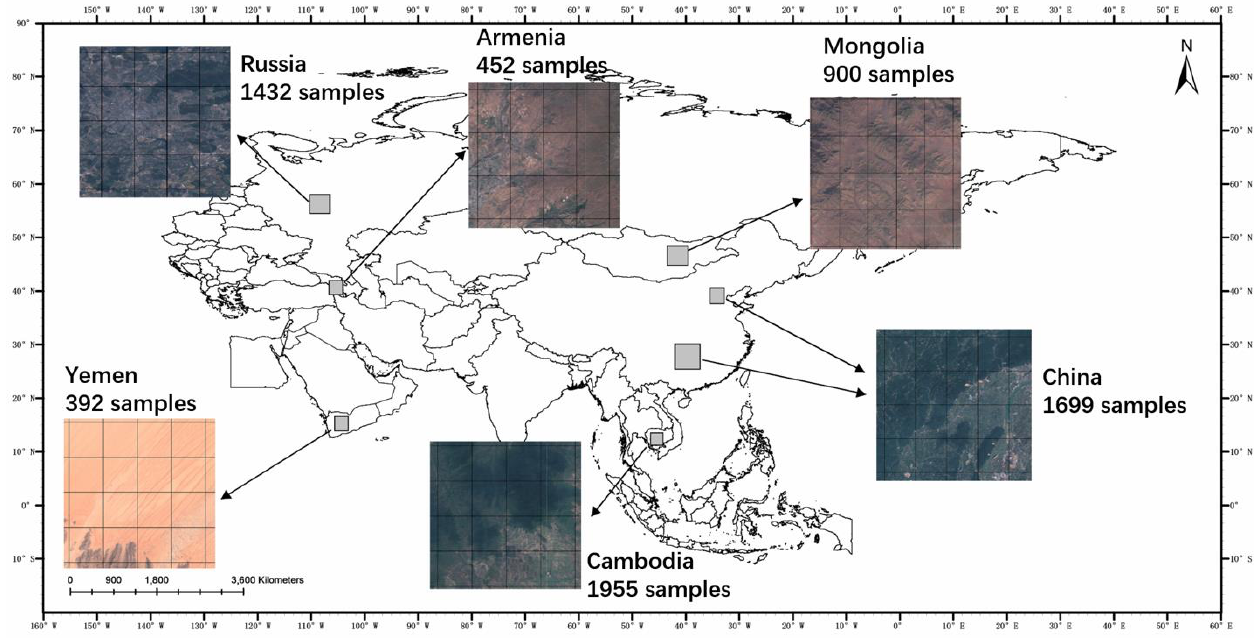
Figure 1. The study area and geographical distribution of samples.